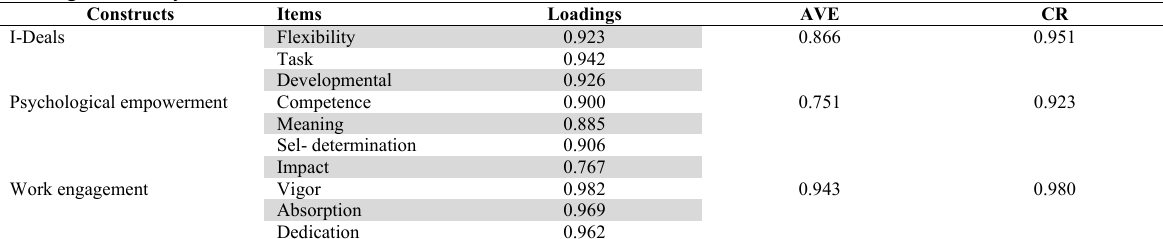
Convergent validity